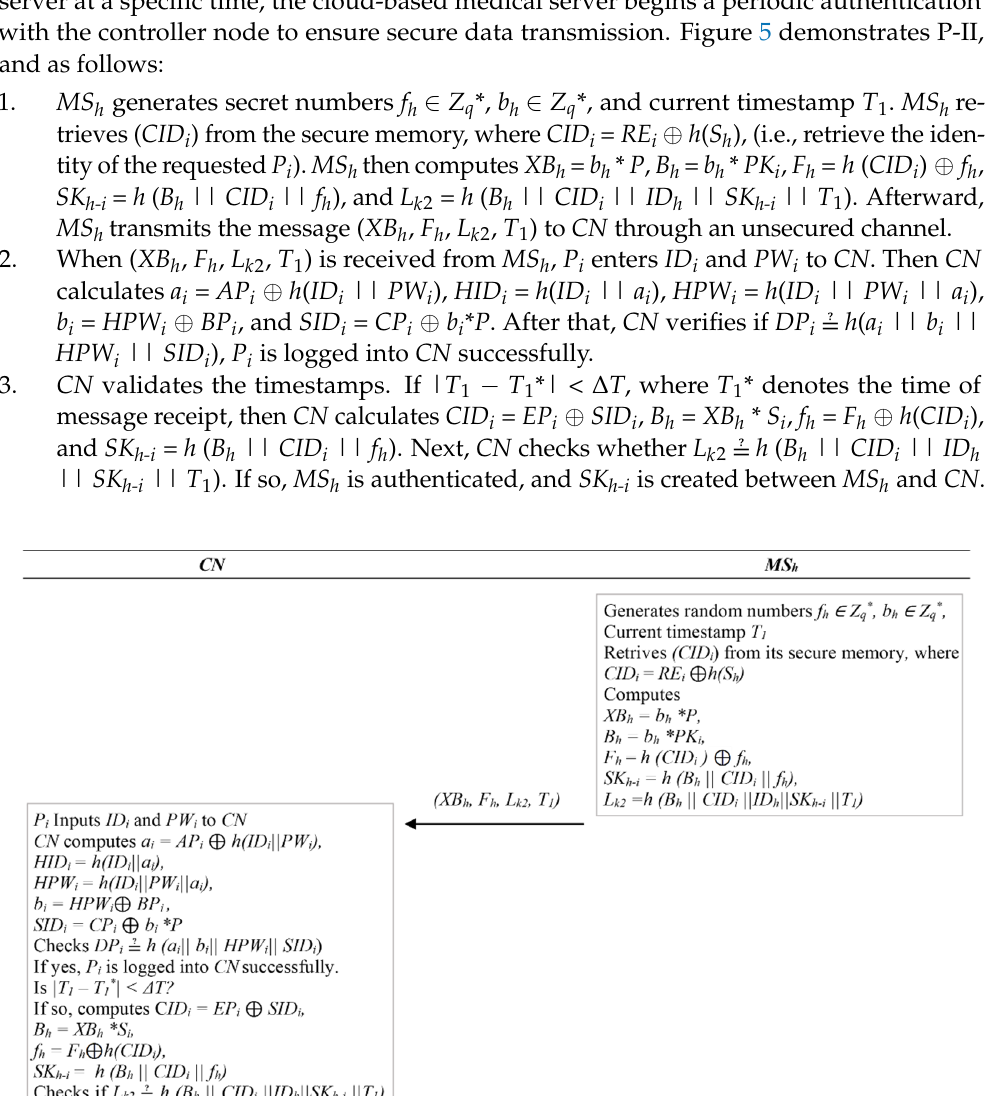
Figure 4. Authentication P-I.